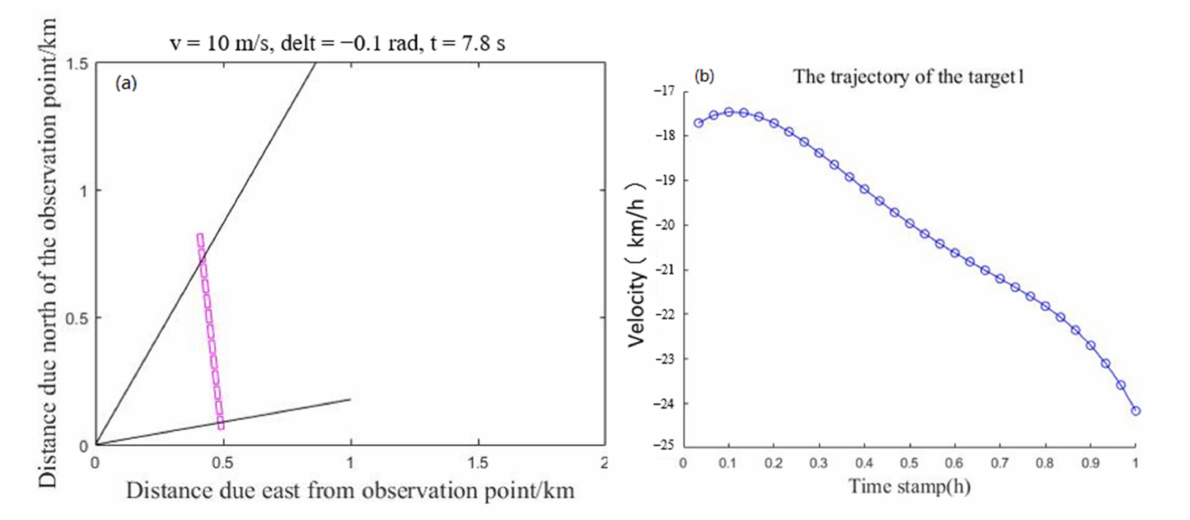
Figure 11. Simulation intention prediction results of rightward ship. ( a ) Simulation of ship movement trajectory. ( b ) Ship speed and direction.